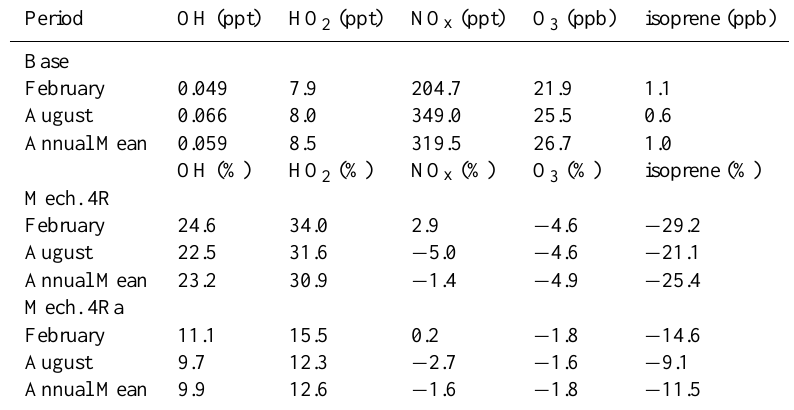
Table 3. Mixing ratio and percentage changes from the base case for a selection of species in a 5 ◦ × 5 ◦ ×∼ 1km grid box centred at 2.5 ◦ N and 117.5 ◦ E representative of Borneo. %=((Sensitivity Run-BASE)/BASE) ·